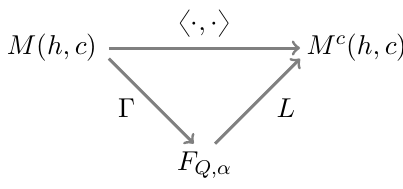
Figure 2 . Route to the Kac determinant.